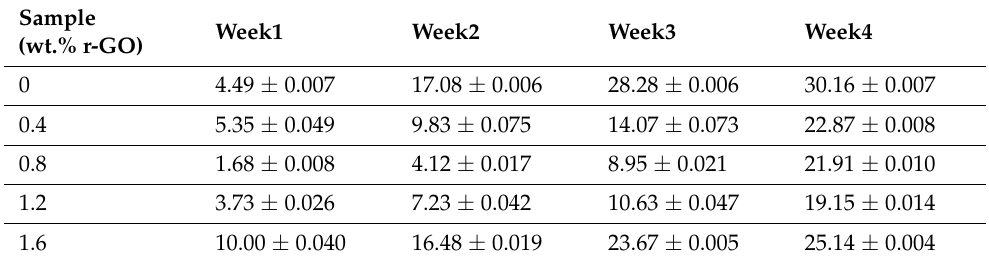
Table 2. Degradation in percentage of hydrogel composite